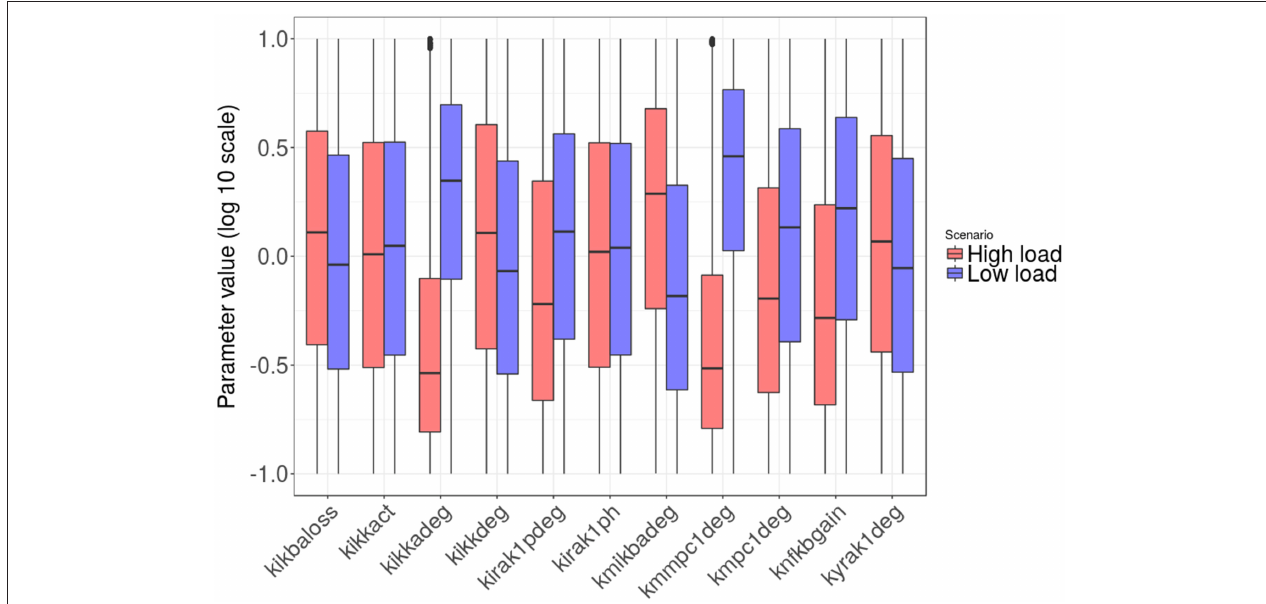
FIGURE 8 | Distribution of the intracellular-level parameter values in the two groups: high load group in red and low load in blue. Only parameters with significant differences between groups are shown.